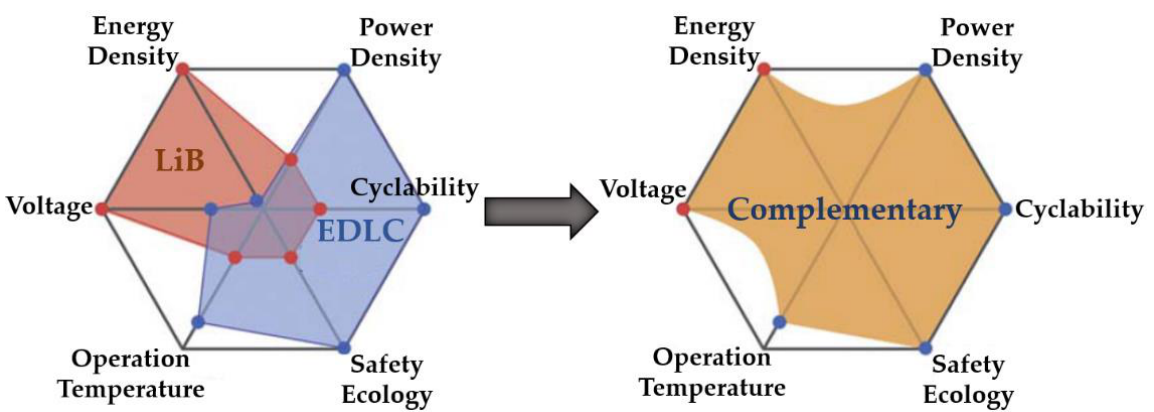
Figure 5. Comparison of LiBs and EDLCs characteristics to form a complementary system [28].